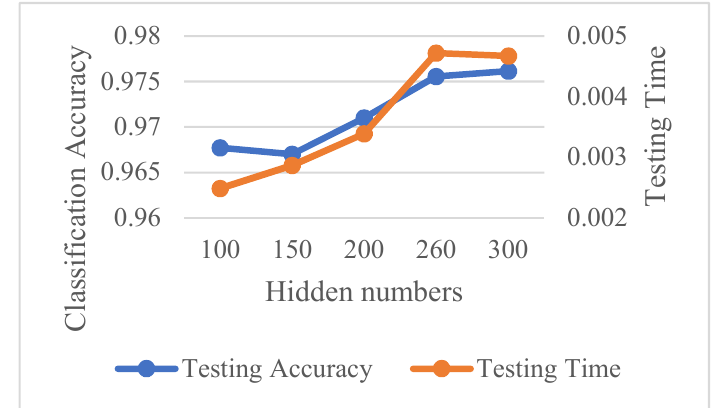
Figure 5. Accuracy and computation time at different hidden layer sizes. The accuracy and computation time at different mini-batch sizes are depicted in Figure 6, when the maximum number of epochs set to 50 and the hidden layer size is set to 300. It can be shown that as the mini-batch size increases from 1 to 7, the accuracy curve and computation time have distinct rise, and then they tend to go down. We select the mini-batch size as